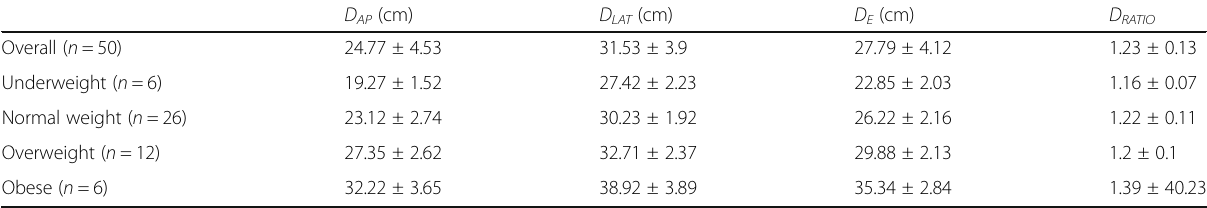
Table 2 Summary of body mass index category and midslice diameter measurements